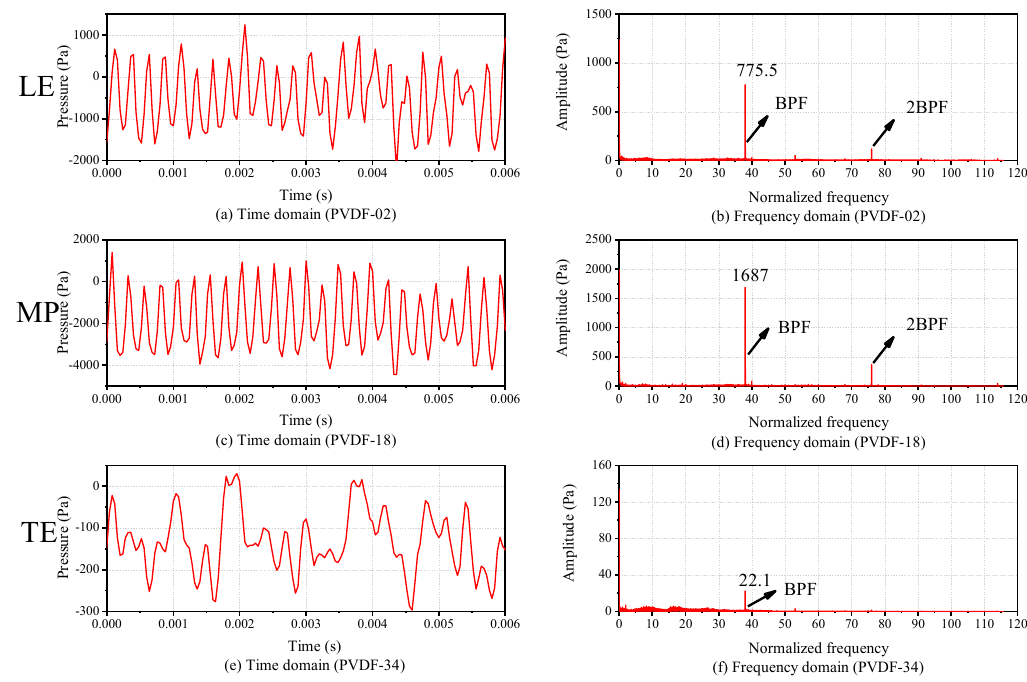
Figure 15. Time domain and frequency domain comparison in axial direction.